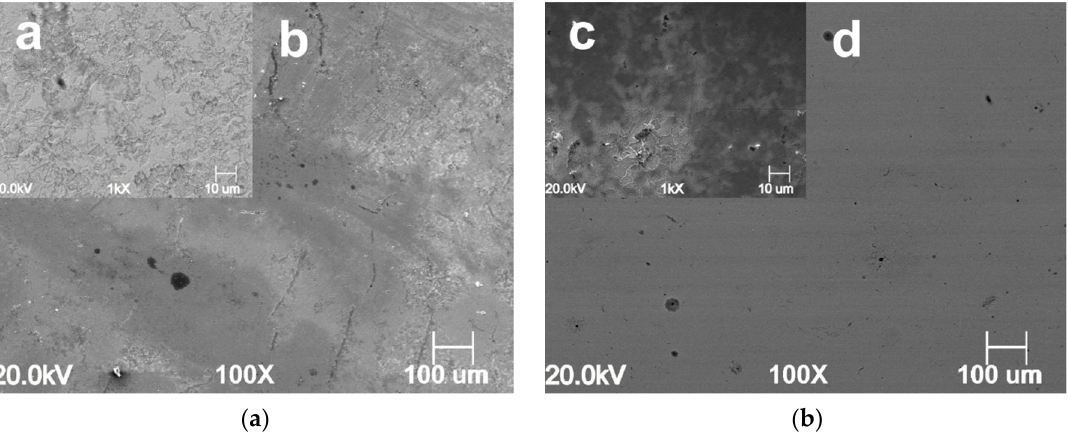
Figure 7. SEM images of the N80 carbon steel surface morphology after 24 h of immersion in the uninhibited (( a ) a lower and b higher magnification) and inhibited (( b ) c lower and d higher magnification) solution at 25 °C and P CO = 1 bar CO 2 .